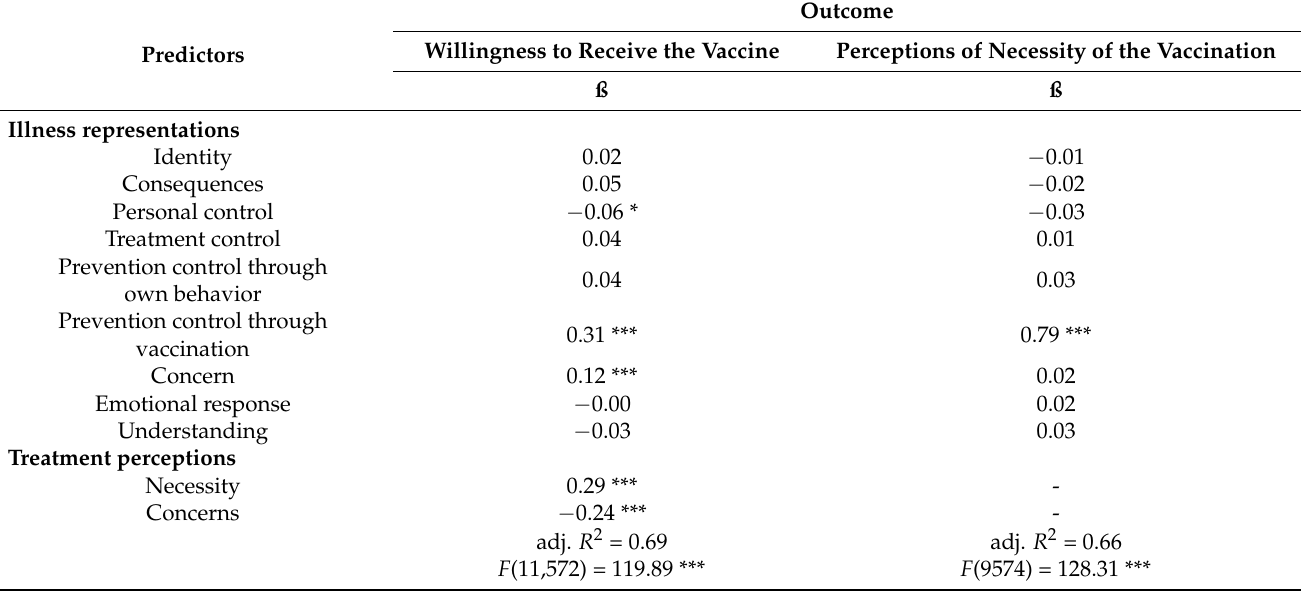
Table 3. Results of the multiple regression